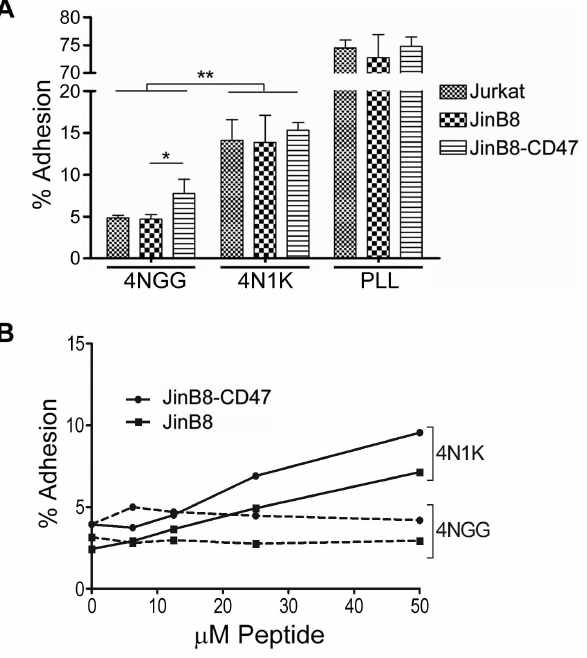
Figure 4. Cells bind to immobilized 4N1K independently of CD47 expression. A) Jurkat, JinB8, or JinB8-CD47 cells pre-labeled with Celltracker Green were added to wells pre-coated with 50 m M 4NGG, 50 m M 4N1K, or 50 m M poly-L-lysine, and incubated for 20 min. In-well fluorescence was measured using a spectrofluorometer both before and after washes to remove non-adherent cells, and % adhesion was calculated as stated in methods and materials. Data as plotted are the means 6 standard deviation for three replicate samples of one experiment (*, p , 0.05; **, p , 0.002) that is representative of three independently conducted experiments. B) Same as in A) but with titrating amounts of 4NGG and 4N1K pre-adsorbed to wells. Data as plotted are the means for samples conducted in